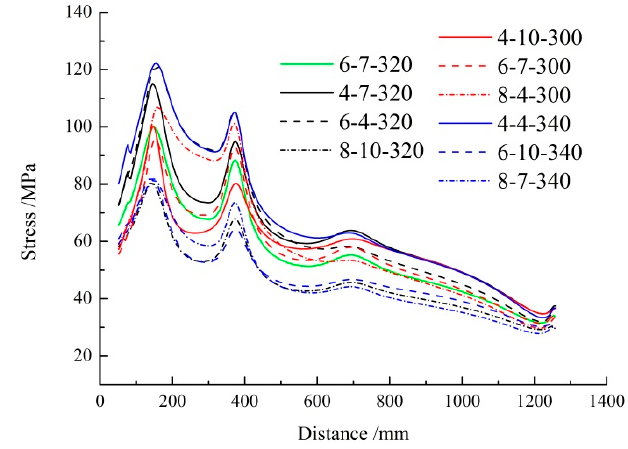
Figure 8. The stresses distributions of weld 1 under vertical conditions.